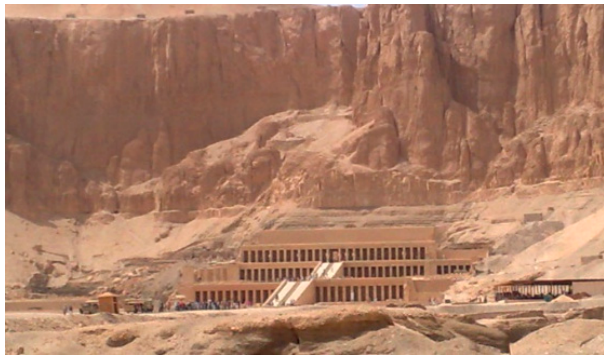
Figure 5. The main façade of Hatshepsut temple at west Luxor.